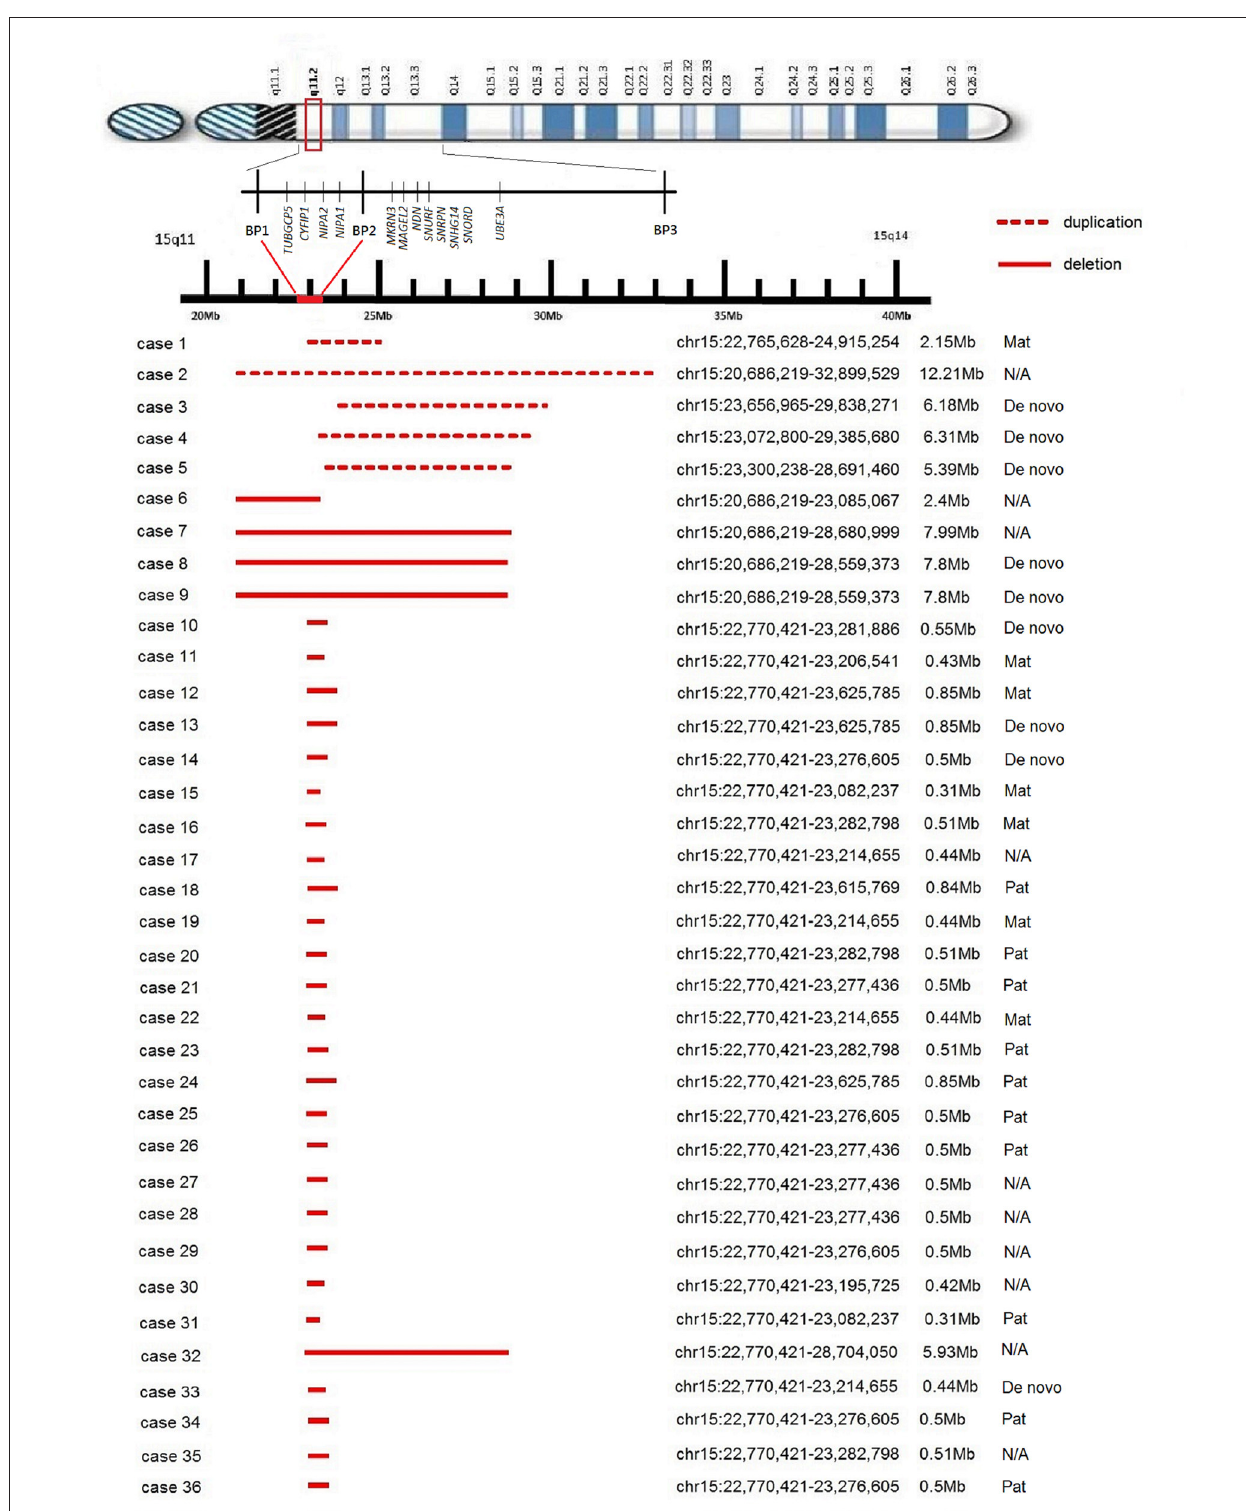
FIGURE 1 | Schematic map of the 15q11.2 BP1-BP2 region. The reported microduplications and microdeletions are shown at the bottom drawn to scale.